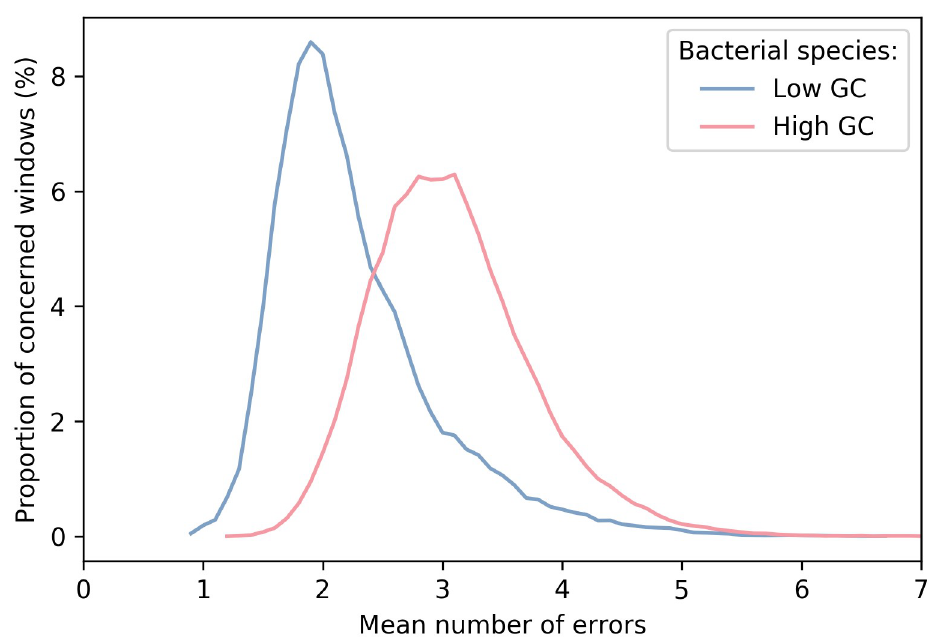
Fig 6. Distribution of read windows according to their error rate. For each bacterial species, we computed the mean number of errors (rounded to the decimal) of read parts that align to windows of size 50 in the reference genome. We expressed the number of errors as the median number of errors for each window and then plotted the global window distribution for both low- and high-GC content species.